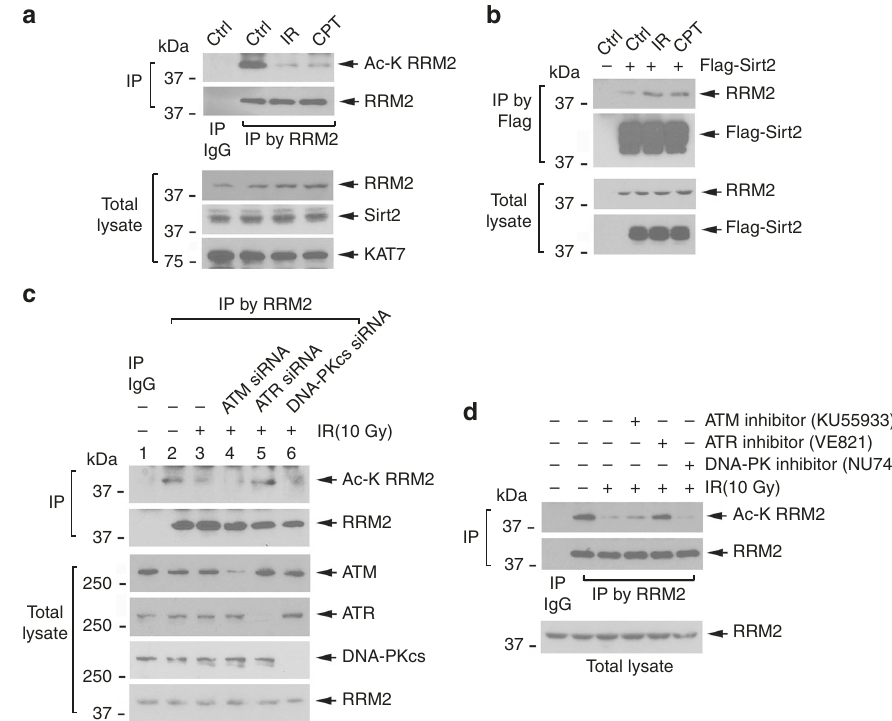
Fig. 6 RRM2 is deacetylated following DNA damage in an ATR-dependent manner. a H1299 cells were exposed to IR (10 Gy) or treated with camptothecin (CPT, 2 µ M) for 6 h, followed by IP with RRM2 antibody, and analysis of RRM2 acetylation. b H1299 cells expressing exogenous Flag-Sirt2 were treated with IR or CPT, followed by co-IP using Flag antibody. Flag-Sirt2-associated RRM2 was analyzed by western blot using RRM2 antibody. c , d H1299 cells were transfected with ATM siRNA, ATR siRNA, or DNA-PKcs siRNA or treated with ATM inhibitor (KU55933, 10 µ M), ATR inhibitor (VE821, 2 µ M),